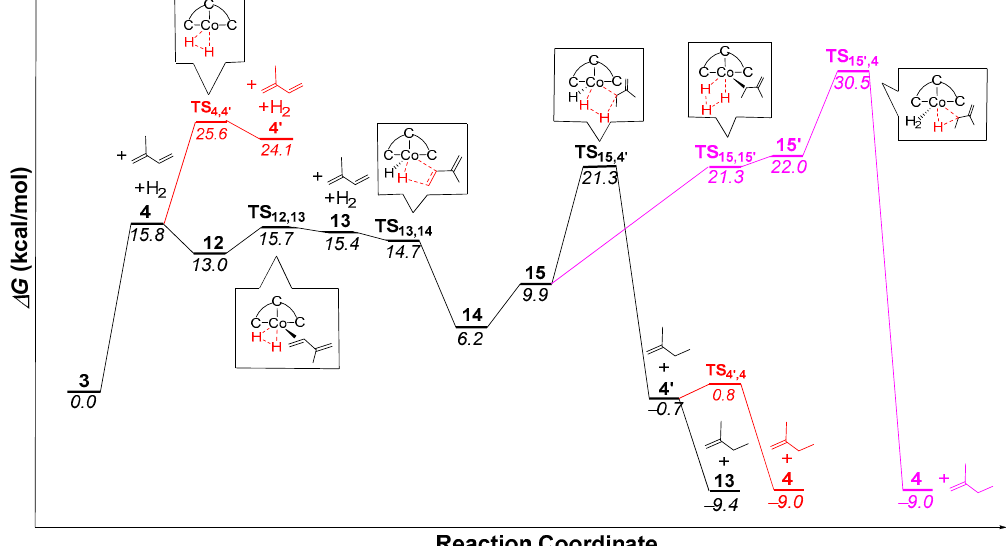
Figure 5. Free energy profile for the hydrogenation of isoprene to 2-methylbut-1-ene catalyzed by ( Mes CCC)Co complexes.